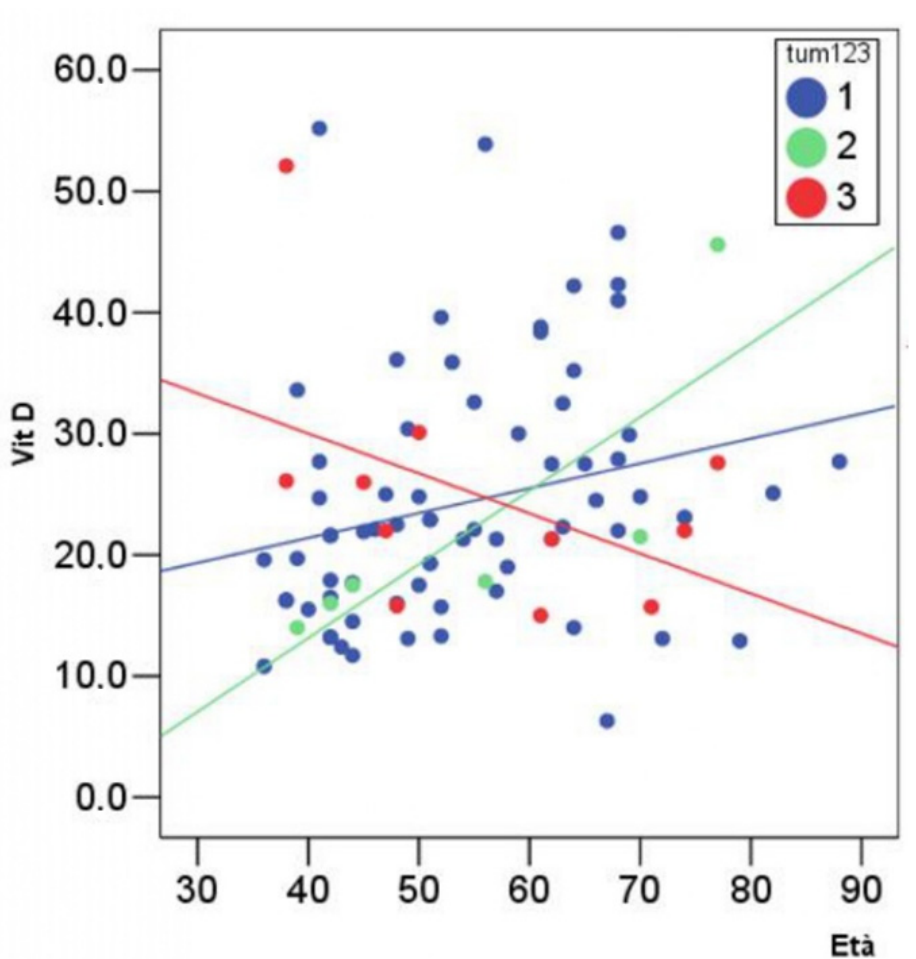
Figure 1. Relationship between age and vitamin D levels in major BC types (tum 1 = ductal BC; tum 2 = in situ BC; and tum 3 = lobular